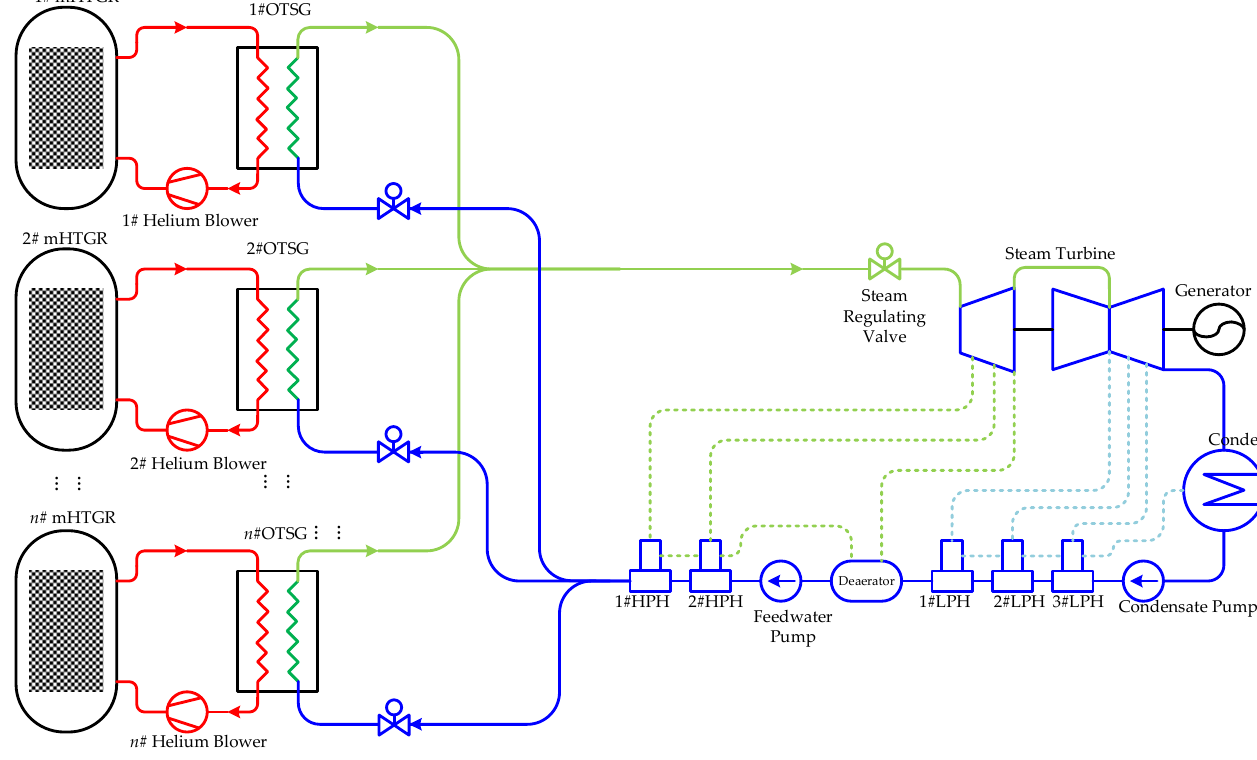
Figure 2. Schematic diagram of a mutimodular mHTGR plant, OTSG: once-through steam generator, HPH: high pressure heater, LPH: low pressure heater. The red lines denote the primary coolant, the blue lines denote the secondary coolant in liquid state, and the green lines denotes the secondary coolant in steam state.